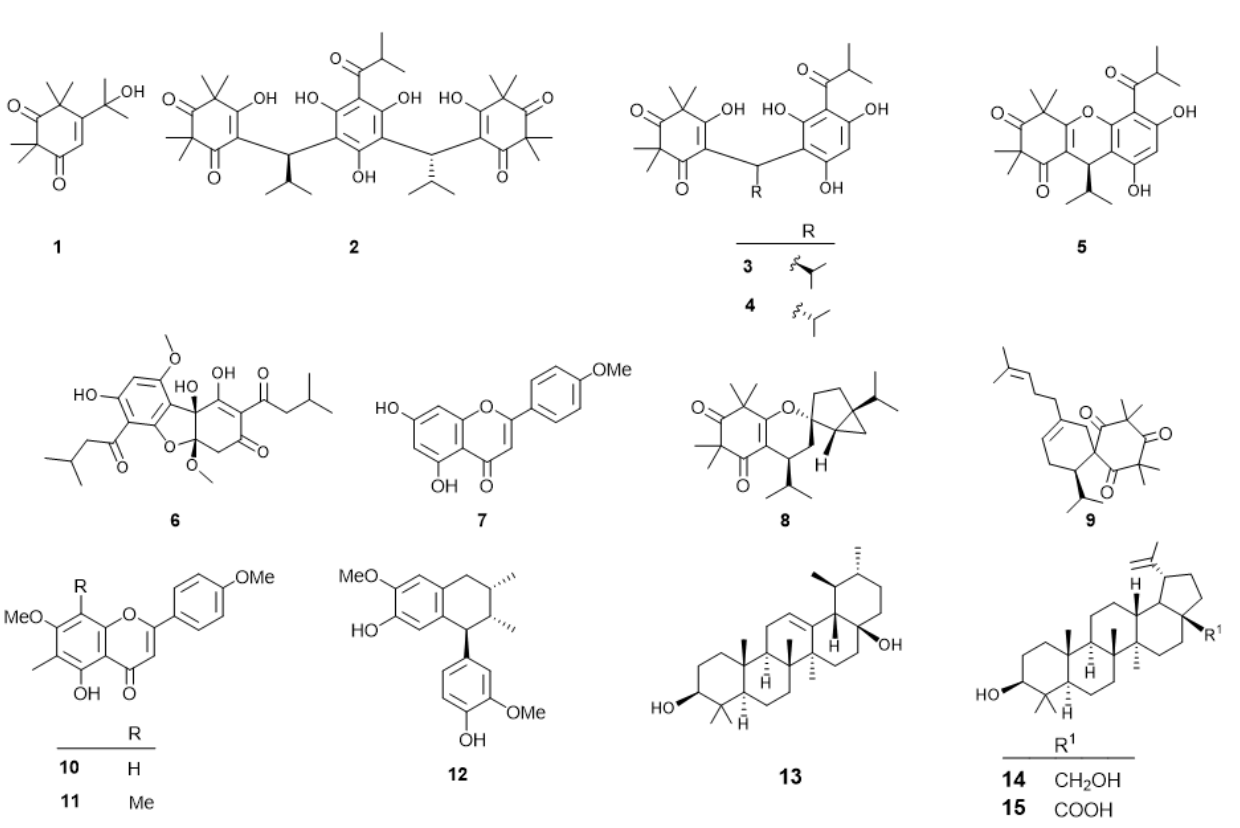
Figure 1. Structures of isolated compounds from C. subulatus leaves.